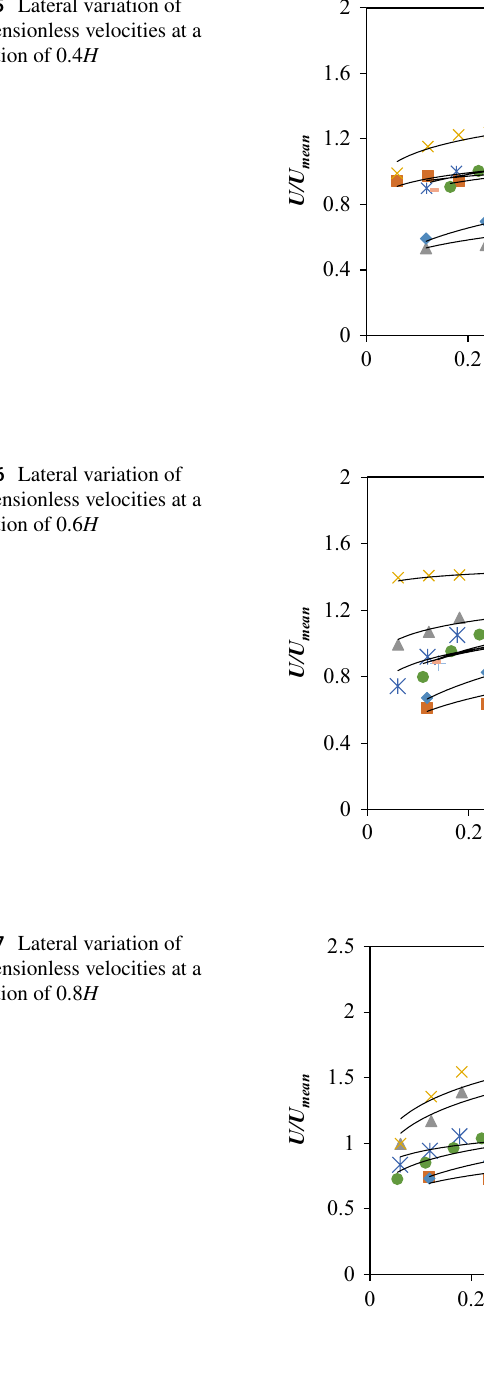
U/U = 0.977{y/(b/2)} 0.247 mean R² = 0.98